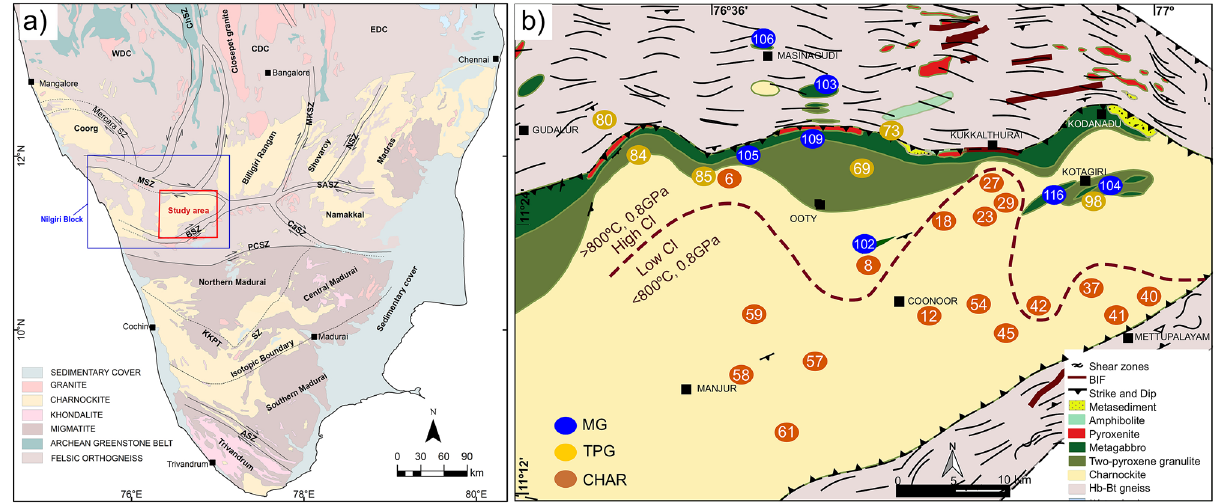
Figure 1. Regional geology and sample locations. ( a ) Regional geology and tectonic framework of southern India (after Ref. 37 ); Blue box outlines the Nilgiri Block. An isotopic boundary divides the Madurai Block into Archean and Mesoproterozoic based on Sm–Nd whole rock and U–Pb ages 38 . ( b ) Geological map of the Nilgiri massif. Sample locations annotated by sample numbers are plotted on the map. The numbers are the same as those used in Ref. 20 , and are also listed in the Extended Data Table 1. Brown-dashed line separates areas of relatively high (> 800 °C) and low (< 800 °C) peak-metamorphic temperatures. CHAR charnockite samples, TPG two-pyroxene granulite samples and MG metagabbro samples. ( a ) Is reproduced by permission from Elsevier (see acknowledgements). ( b ) Is created using QGIS 2.6.1 (https:// www. qgis. org/ en/ site/); ( a ) and ( b ) are modified using Inkscape version 0.92.2 (https:// inksc ape.